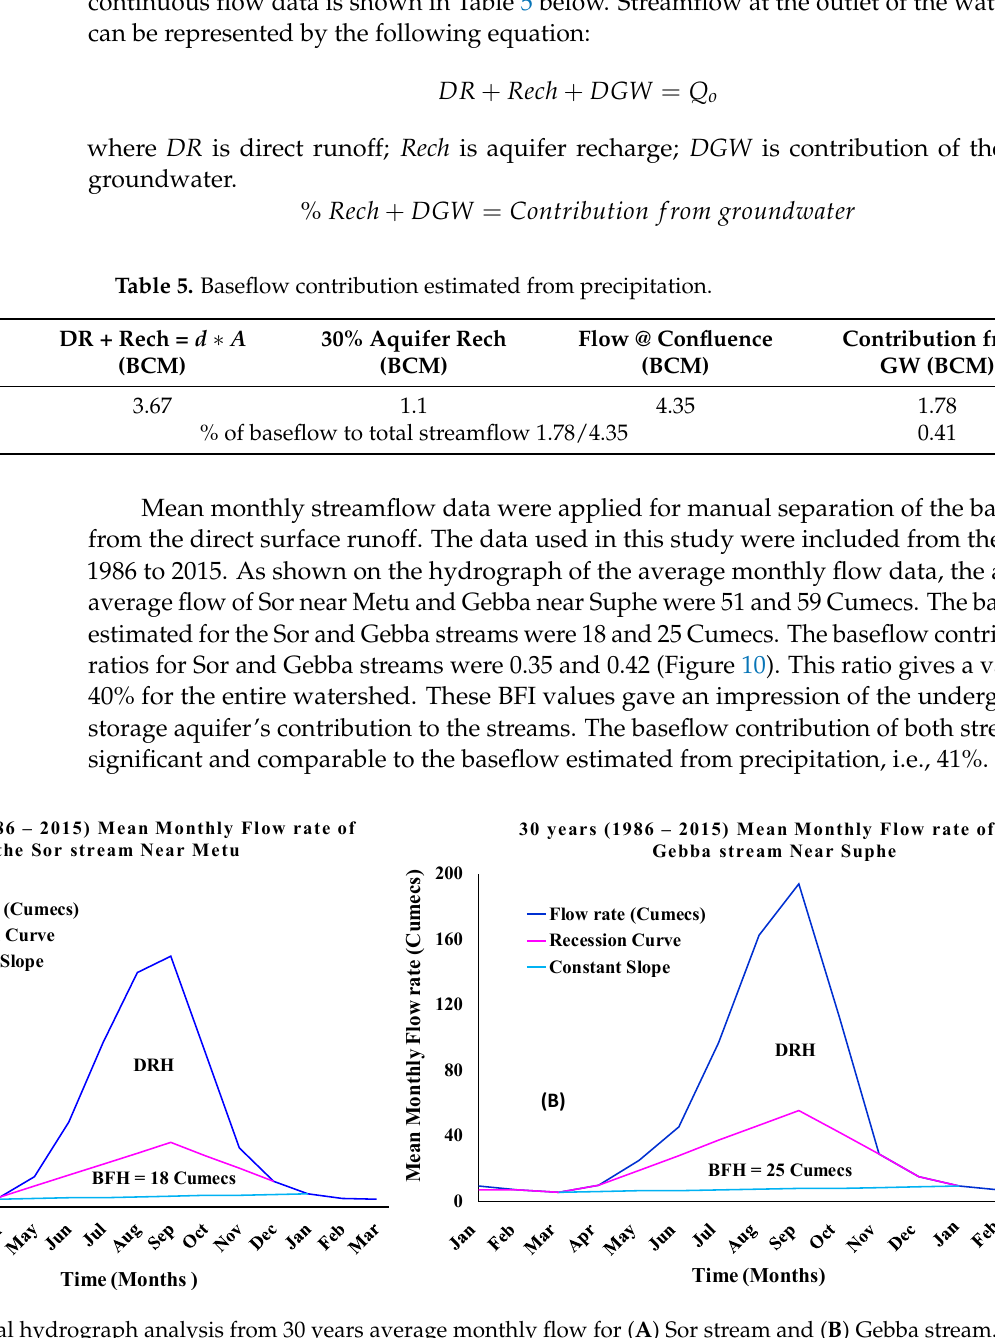
Table 4. Sor and Gebba average values of BFI from FDC and manual average.